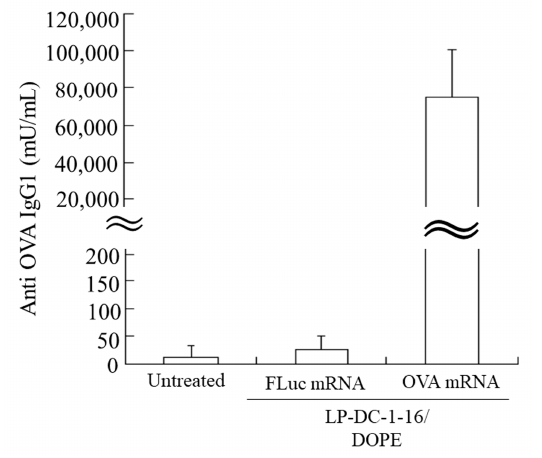
Figure 10. Induction of anti-OVA IgG1 after IV injection of OVA mRNA lipoplexes. LP-DC-1-16/DOPE lipoplexes with 20 µg FLuc mRNA (5moU) or OVA mRNA (5moU) were systemically injected into the mice on days 0 and 14. Blood was collected from immunized mice on day 28, and OVA-specific IgG1 in serum was quantified. Each column represents the mean + S.D. ( n = 4). OVA: ovalbumin.